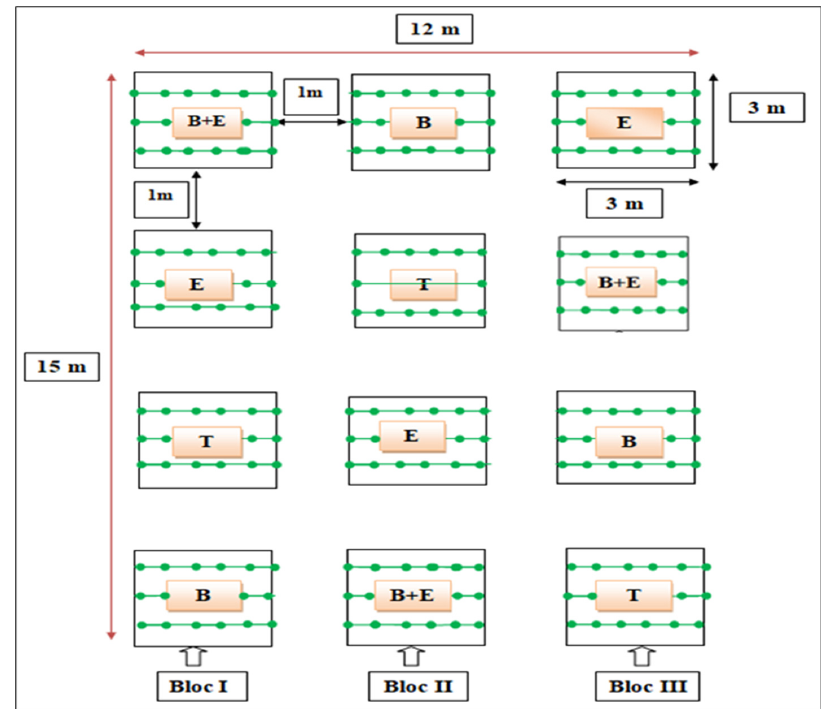
Figure 1. Representative schema of experimental field Table 1. Physicochemical parameters of soil before application of sewage sludge